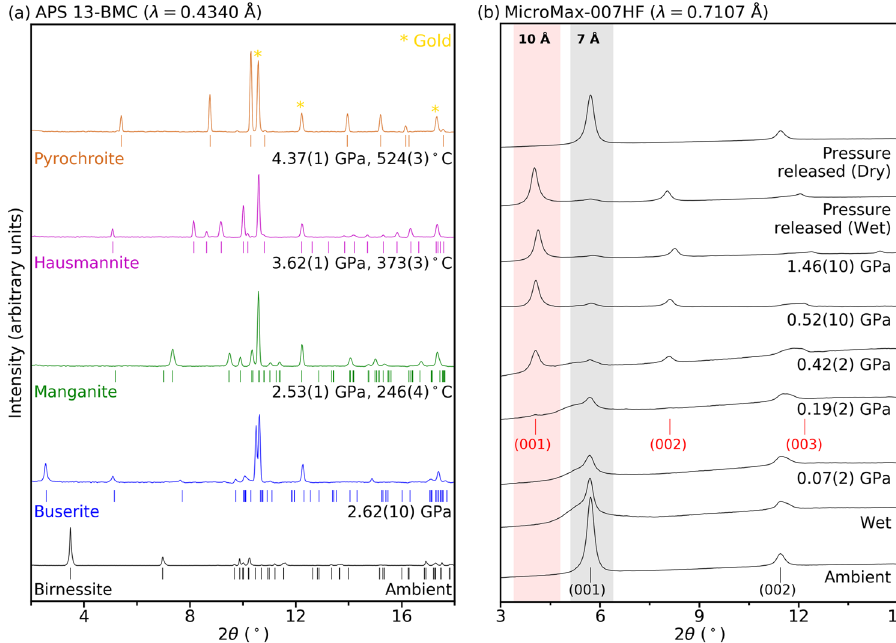
Fig. 1 Synchrotron X-ray diffraction patterns showing successive transformations from birnessite. a Selected XRD patterns measured in-situ high- pressure conditions in water medium at the 13-BM-C beamline at APS. b Super-hydration of birnessite into buserite in a kilobar pressure regime. ‘ Wet ’ and ‘ Dry ’ indicate two different sample conditions at ambient pressure in water and after exposure to atmospheric humidity, respectively.